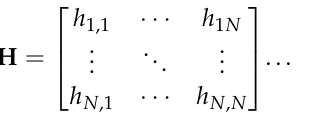
where σ 2 and σ 2 are variances of thermal and shot noises, respectively. The channel thermal shot